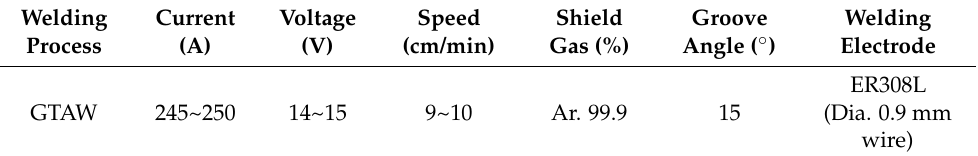
Table 2. Welding conditions of the experimental specimen (Reprinted with permission from [36]. 2022, MDPI).